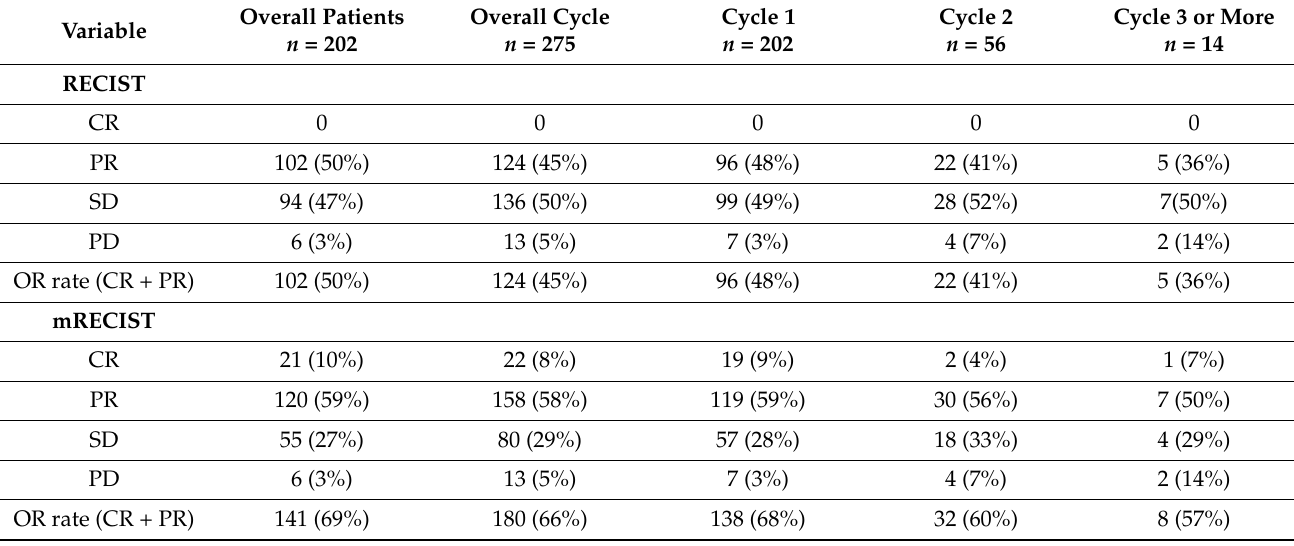
Table 3. Tumor response according to RECIST and